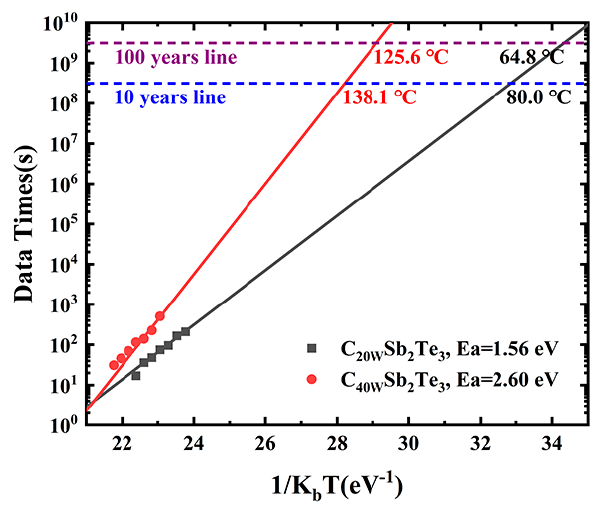
Figure 7. The 10-year (or 100-year) data retention temperature and activation energy of crystallization are deduced based on the Arrhenius equation, according to the failure time versus reciprocal temperature.